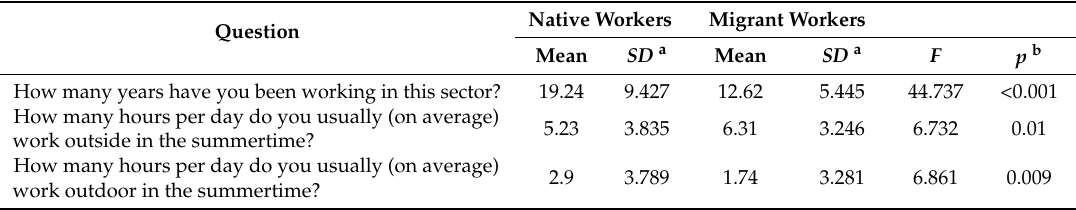
Table 4. ANOVA analysis